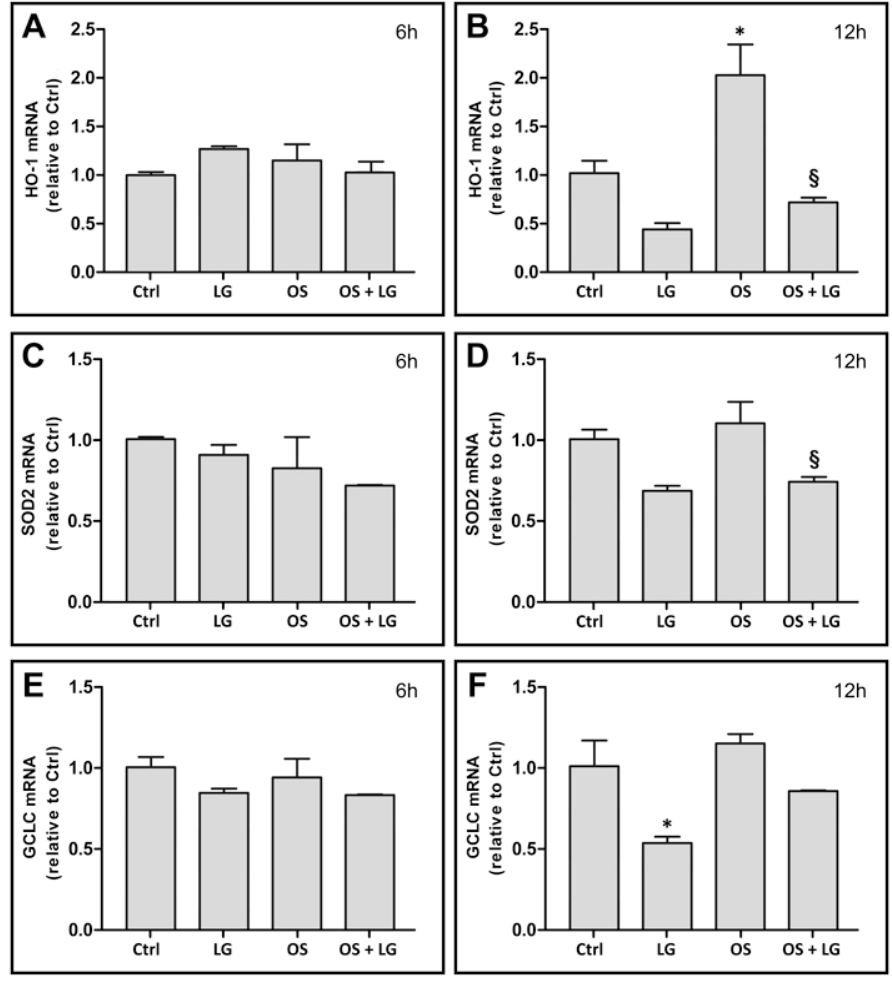
Figure 3. Heme oxygenase-1 (HO-1, ( A , B )), superoxide dismutase 2 (SOD2, ( C , D )), and glutamate-cysteine ligase catalytic subunit (GCLC, ( E , F )) mRNA expression in retinal explants after 6 h ( A , C , E ) or 12 h ( B , D , F ) incubation. LG was administered at a concentration of 0.67 µ g/mL. Each column represents mean ± SD. * p < 0.05 vs. Ctrl at 12 h; § p < 0.05 vs. OS at 12 h; n = 3 for all measures. Power value in ( B , D , F ) is 0.80.